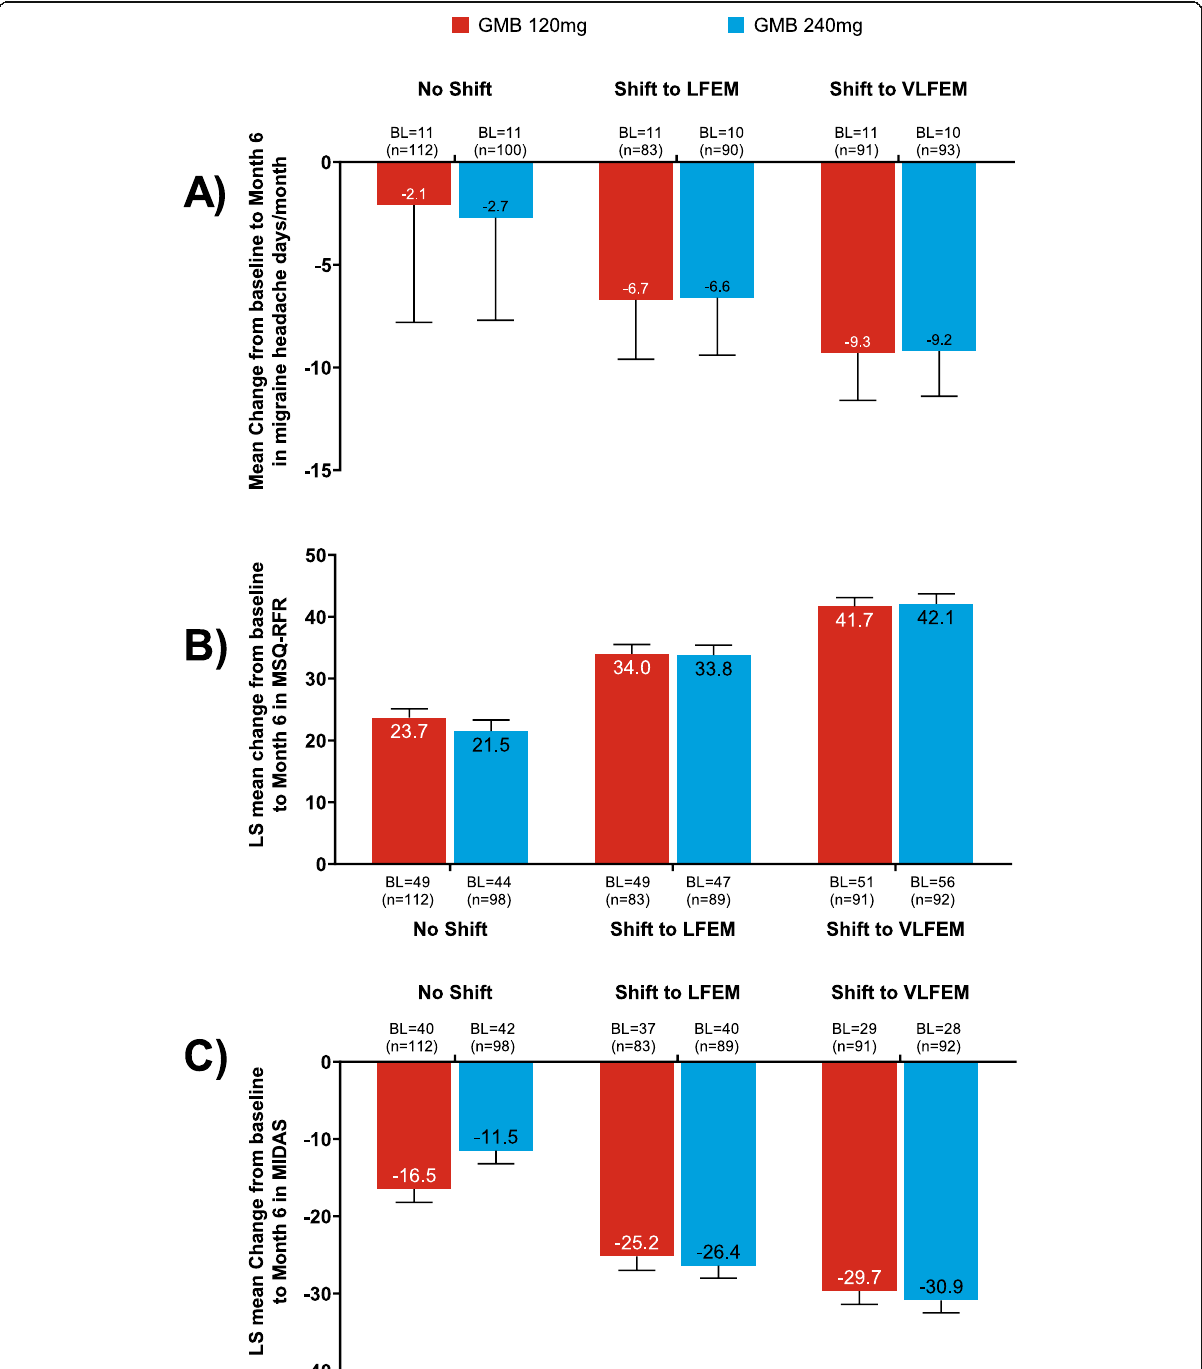
Fig. 4 Change from baseline to Month 6 in HFEM patients receiving galcanezumab who 1) did not shift, 2) shifted to LFEM or 3) VLFEM for ≥ 3 consecutive months until the end of the study for ( a ) migraine headache days/month, ( b ) MSQ-RFR score and ( c ) MIDAS total score. All P < .001 shift from ‘ HFEM status to LFEM status ’ versus ‘ no shift ’ and to ‘ VLFEM status ’ versus ‘ no shift ’ . The between group comparisons for migraine headache days/month (panel a ) were done using ANOVA with raw mean changes and standard deviation shown, whereas MSQ (panel b ) and MIDAS (panel c ) were analyzed using ANCOVA models adjusted for covariates with estimated least squares means and standard errors displayed. Abbreviations: ANOVA, Analysis of Variance; ANCOVA, Analysis of Covariance; BL, baseline; GMB, galcanezumab; HFEM, high-frequency episodic migraine; HFEM, low-frequency episodic migraine; MIDAS, Migraine Disability Index, MSQv2.1 RFR, Migraine-Specific Questionnaire Version 2.1 Role Function Restrictive, VLFEM, very low-frequency episodic